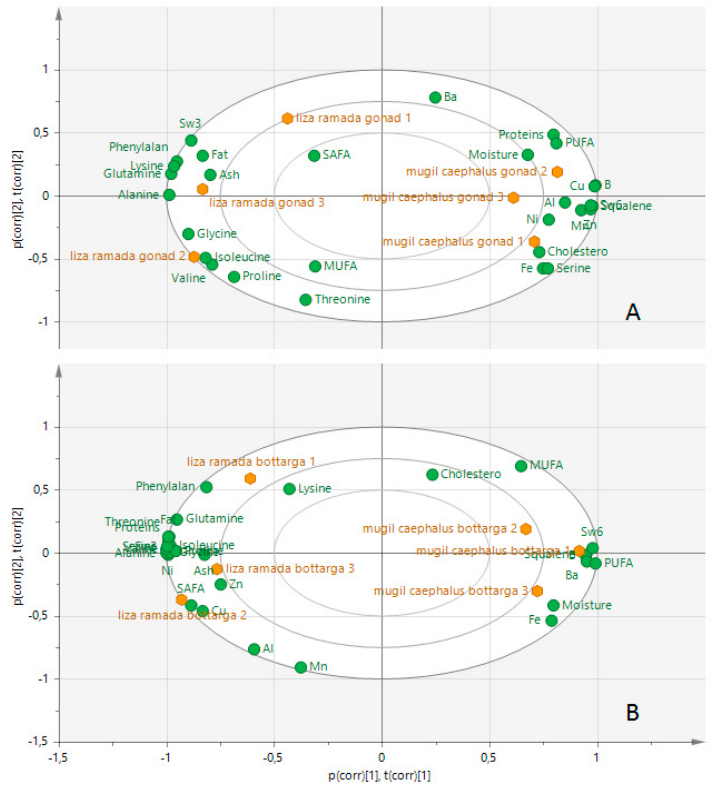
Figure 3. Biplot from PCA analysis of the samples of fresh roe (gonads) ( A ), and bottarga ( B ) from Liza ramada vs. Mugil cephalus .